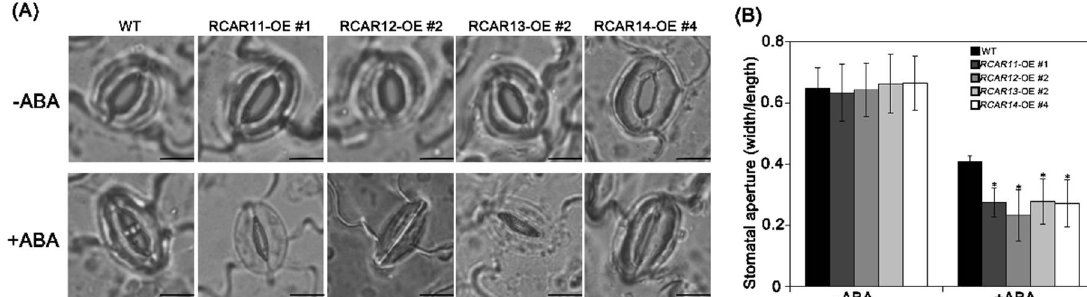
Figure 5. The RCAR11/12/1/14 induces ABA-mediated stomatal movement in transgenic Arabidopsis . ( A ) Stomatal closure of the WT and transgenic plants after 30 μM ABA treatment for 3 h; ( B ) Statistical analysis of the plants’ stomatal aperture (the ratio of width to length) shown in ( A ). Values are means ± SD ( n = 50). * p < 0.05, Student’s t -test. Bar = 10 μm.